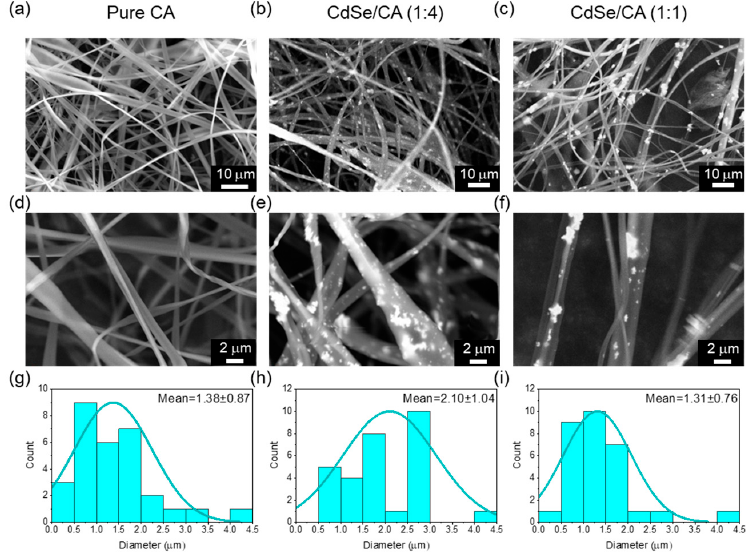
Figure 1. ( a – f ) Field emission scanning electron micrographs (FE-SEM) images and ( g – i ) fiber diameter distributions of CA, CdSe-CA (1:4), and CdSe-CA (1:1) fibers, respectively.